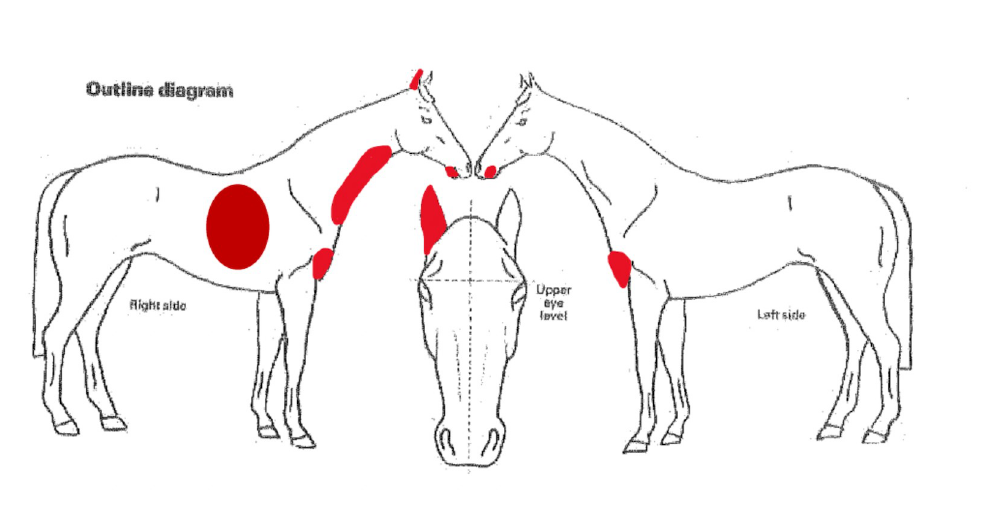
Fig 1. Assessed skin regions: The right side of the neck, the right side of the chest, the lip area, the right auricle and the